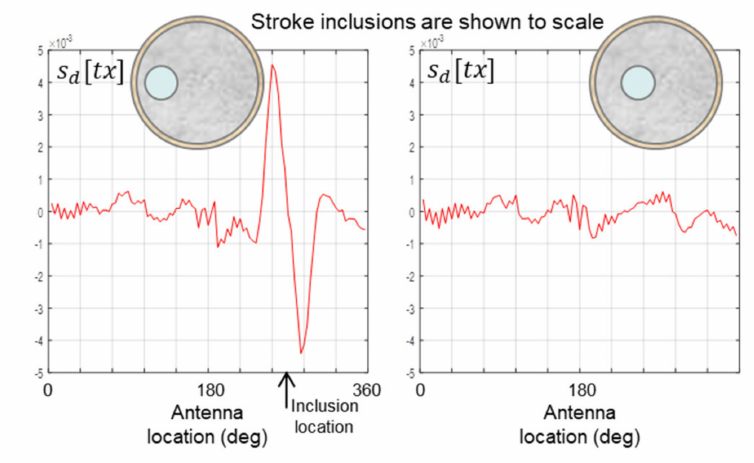
Figure 14. Data from scans of progressively deeper 44 mm inclusions in the 175 mm phantom. The data plots reported thus far all derive from scans in which the stroke inclusion is located at 9 o’clock on a clock face. As stated at the start of this section, that was done to ensure consistency across those data plots and to facilitate valid comparisons between the plots. However, in order to confirm that the signature is indeed caused by the stroke inclusion and is not an artefact of the scanning apparatus or the surrounding environment that just happens to be at the correct location, the additional scans in Figure 15 were carried out with the inclusion located at 12 o’clock and 3 o’clock. The resulting data plots confirm that the location of the signature correctly tracks the actual location of the inclusion.